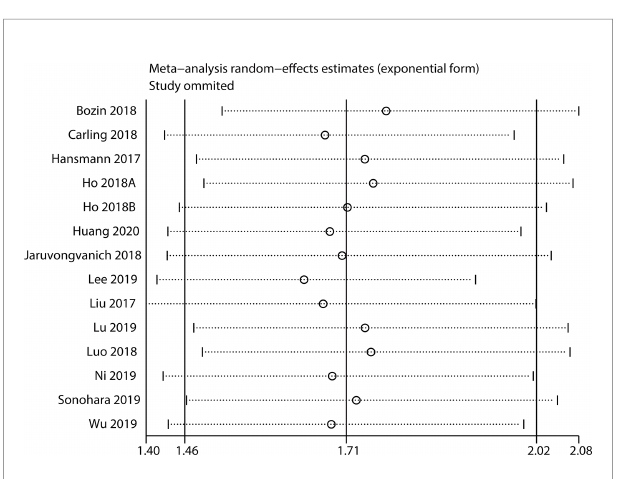
FIGURE 5 | Sensitivity analysis for OS.